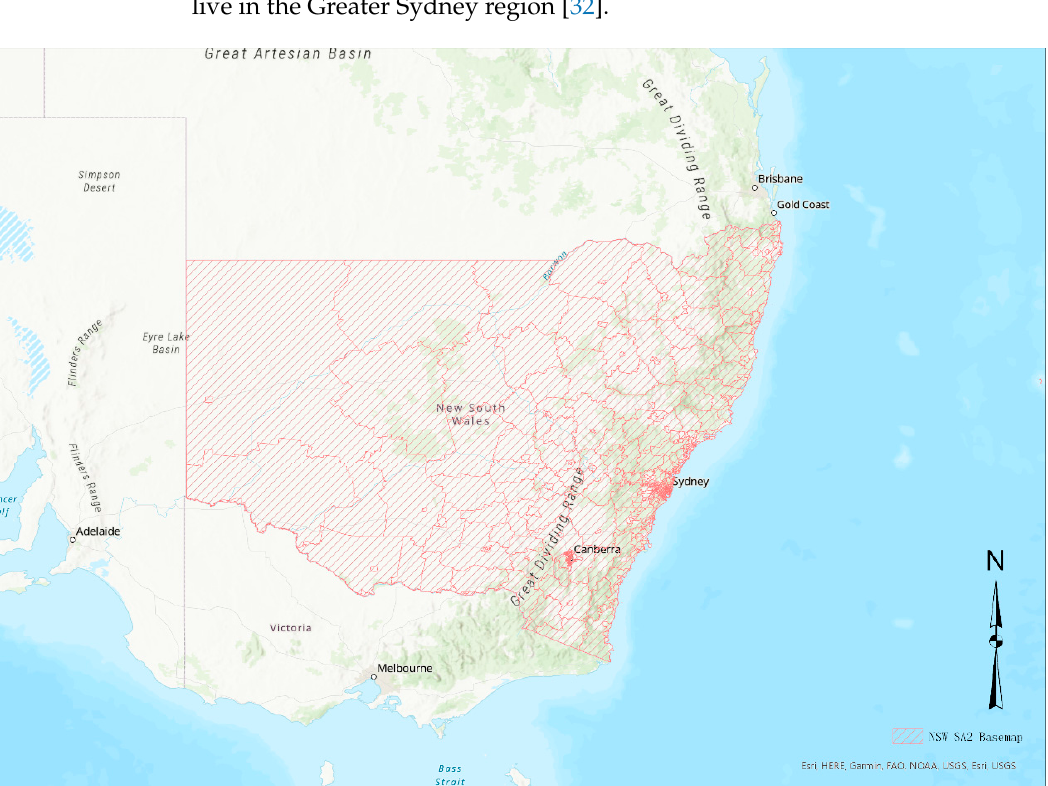
Figure 2. Study area.